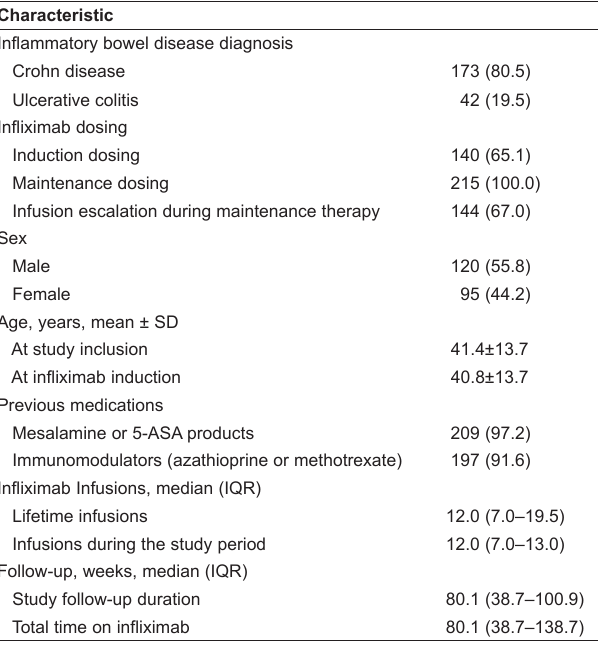
Table 1 baseline patient demographics of 215 inflammatory bowel